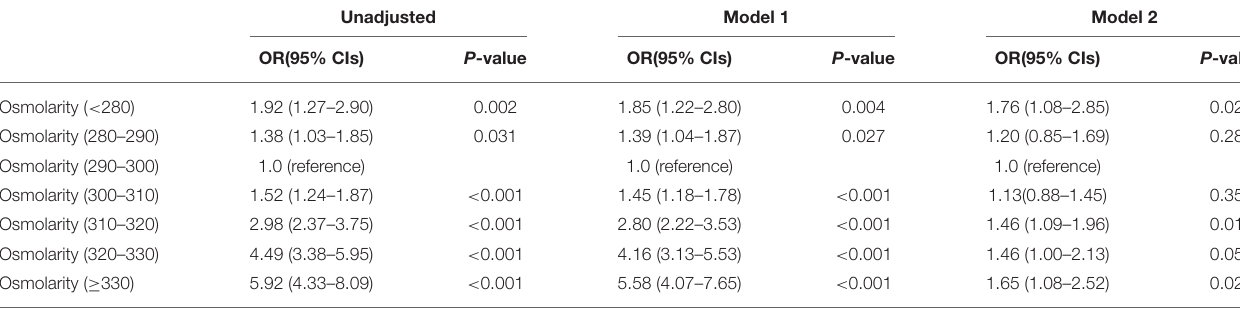
TABLE 3 | The association between in-hospital mortality and osmolarity (mmol/L).